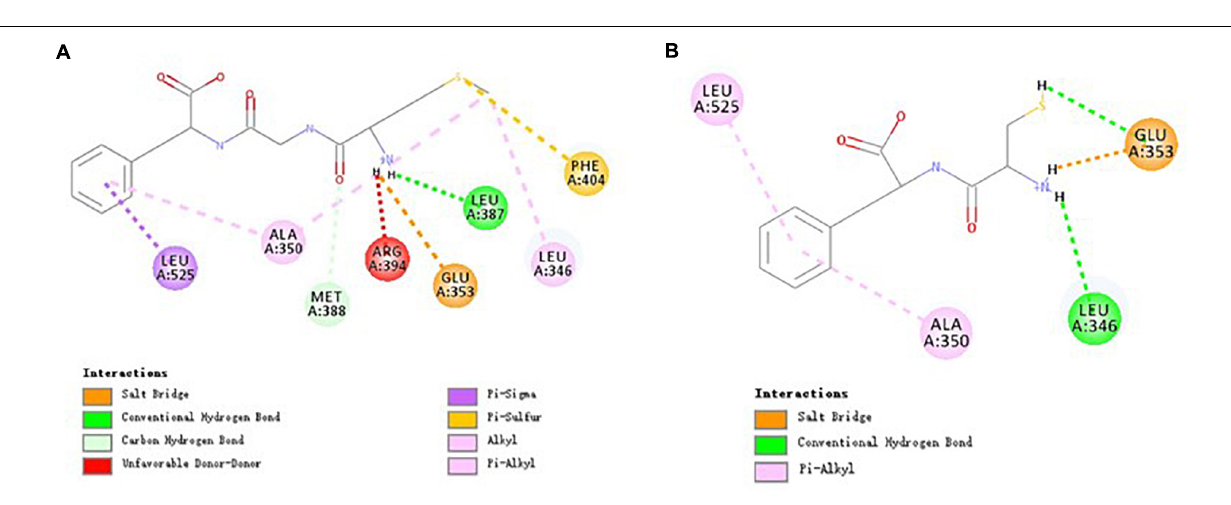
osteoblasts proliferation through activating p44/42 MAP